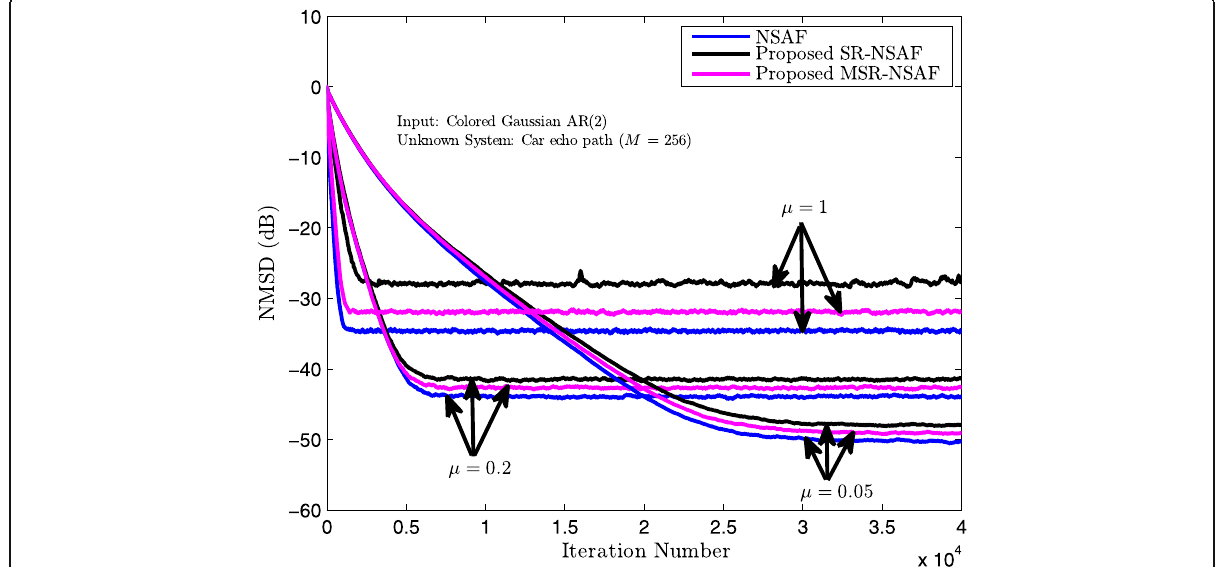
Fig. 4 NMSD learning curves of NSAF, SR-NSAF, and MSR-NSAF with N = 4 and different values of μ